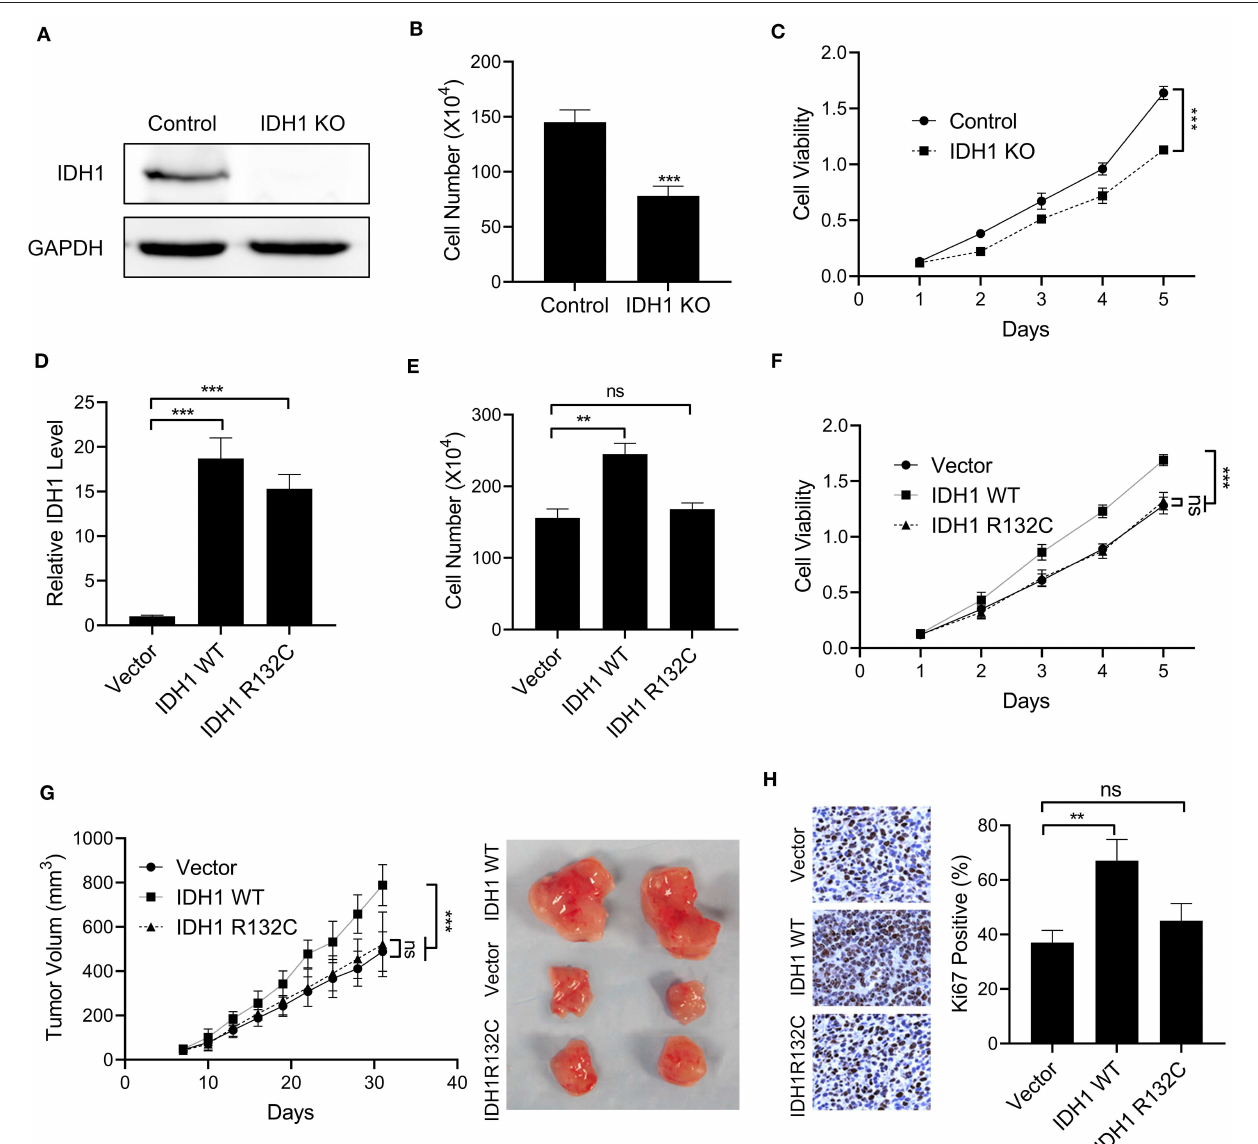
FIGURE 2 | The overexpression of IDH1 promoted cell proliferation of cholangiocarcinoma. (A) Western blot was used to determine the expressions of IDH1 in the IDH knockout (KO) REB cells. Cell count assay (B) and MTT assay (C) were used to determine the cell viabilities of REB and IDH1 KO REB cells. (D) qPCR was used to determine the relative expressions of IDH1 in IDH1 KO REB cells transfected with vector, plasmids containing wildtype IDH1 or plasmids containing IDH1 R132C mutation sequence. Cell count assay (E) and MTT assay (F) were used to determine cell viabilities of IDH1 KO cells transfected with vector, plasmids containing wildtype IDH1 or plasmids containing IDH1 R132C mutation type. (G) The tumor volume of xenograft mouse transplanted with IDH1 KO REB cells transfected with vector, wildtype IDH1 or IDH1 R132C mutation plasmid. (H) Immunohistochemistry demonstrated percentage of Ki67 positive in tumor tissue from each group. Data are shown as mean ± S.D. ** P < 0.01, *** P < 0.001; ns indicates no significance.